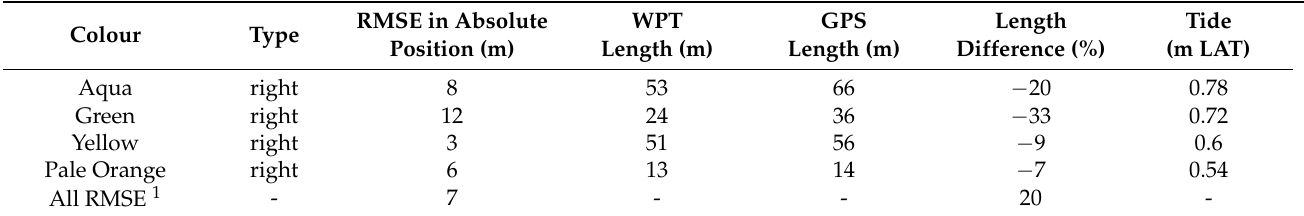
Table 1. GPS tracks compared with WPTs in the reef region.